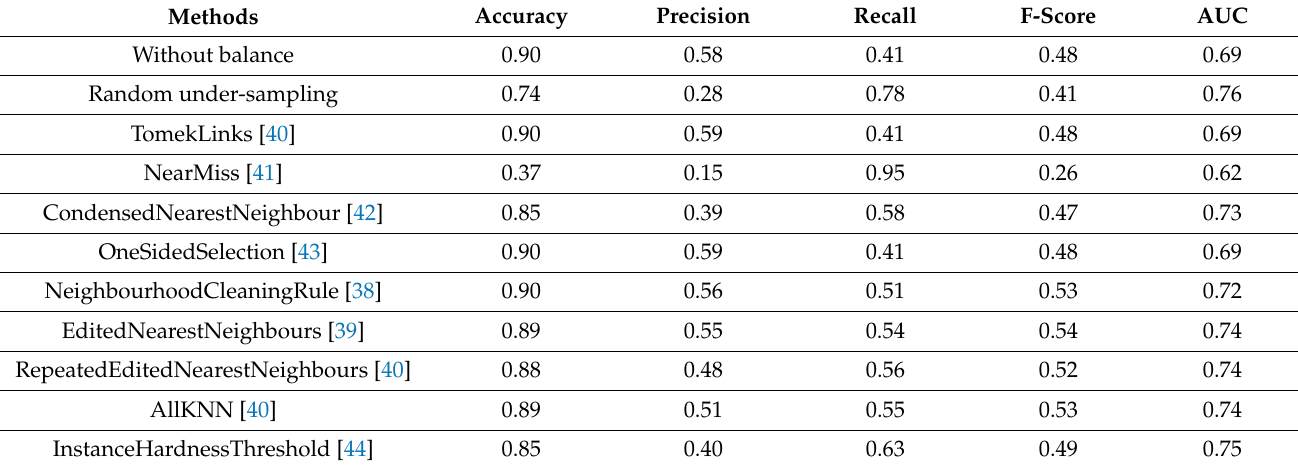
Table 3. Results of different methods with an under-sampling